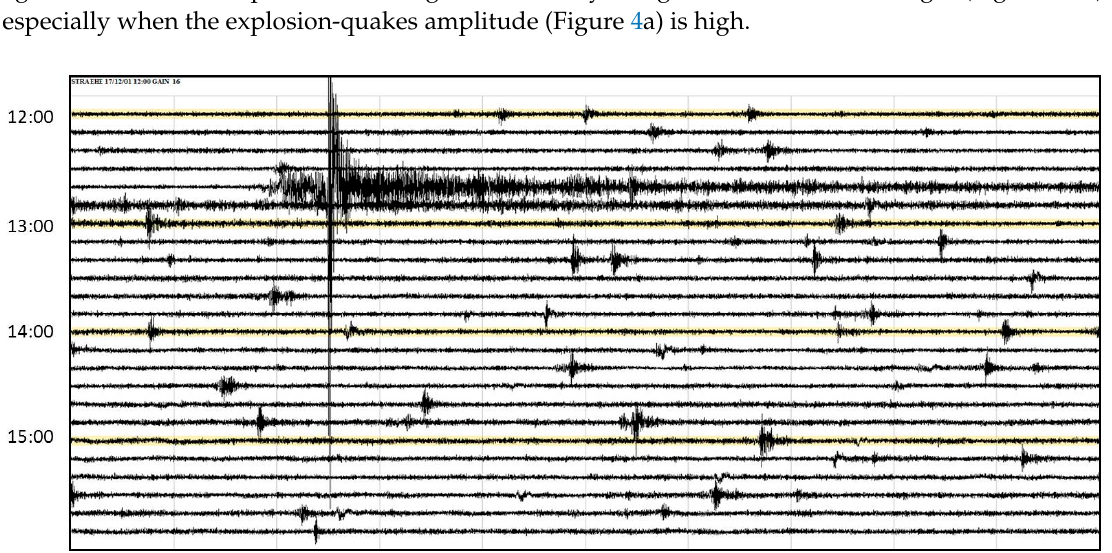
Figure 4. The major explosion occurred on 1 December 2017 at 12:42:30 UTC and the background explosive seismicity of Stromboli volcano due to the ordinary explosions (STRA east-west component). Time ranges from 12:00 to 16:00 UTC. The signal amplitude is expressed in counts. The distance between the two lines is the equivalent to 2048